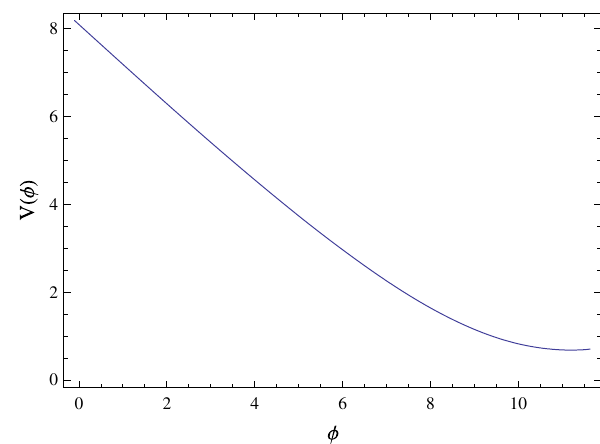
Fig. 31 Variation of f (φ) with the variation of φ for the Efstathiou parameterization (Model IV). Fig. 32 Variation of V